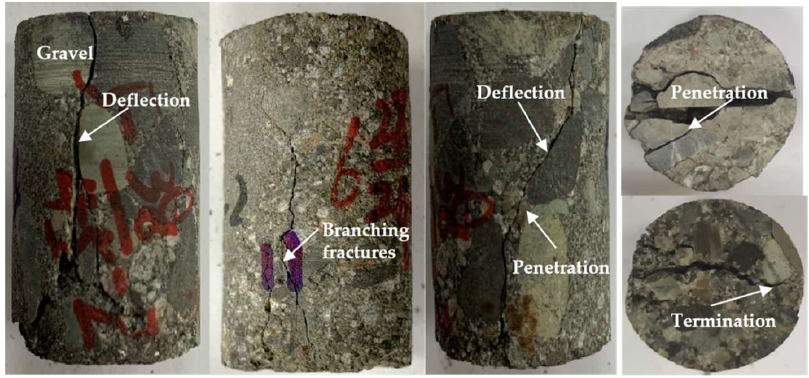
Figure 2 . Core fracture experiment.